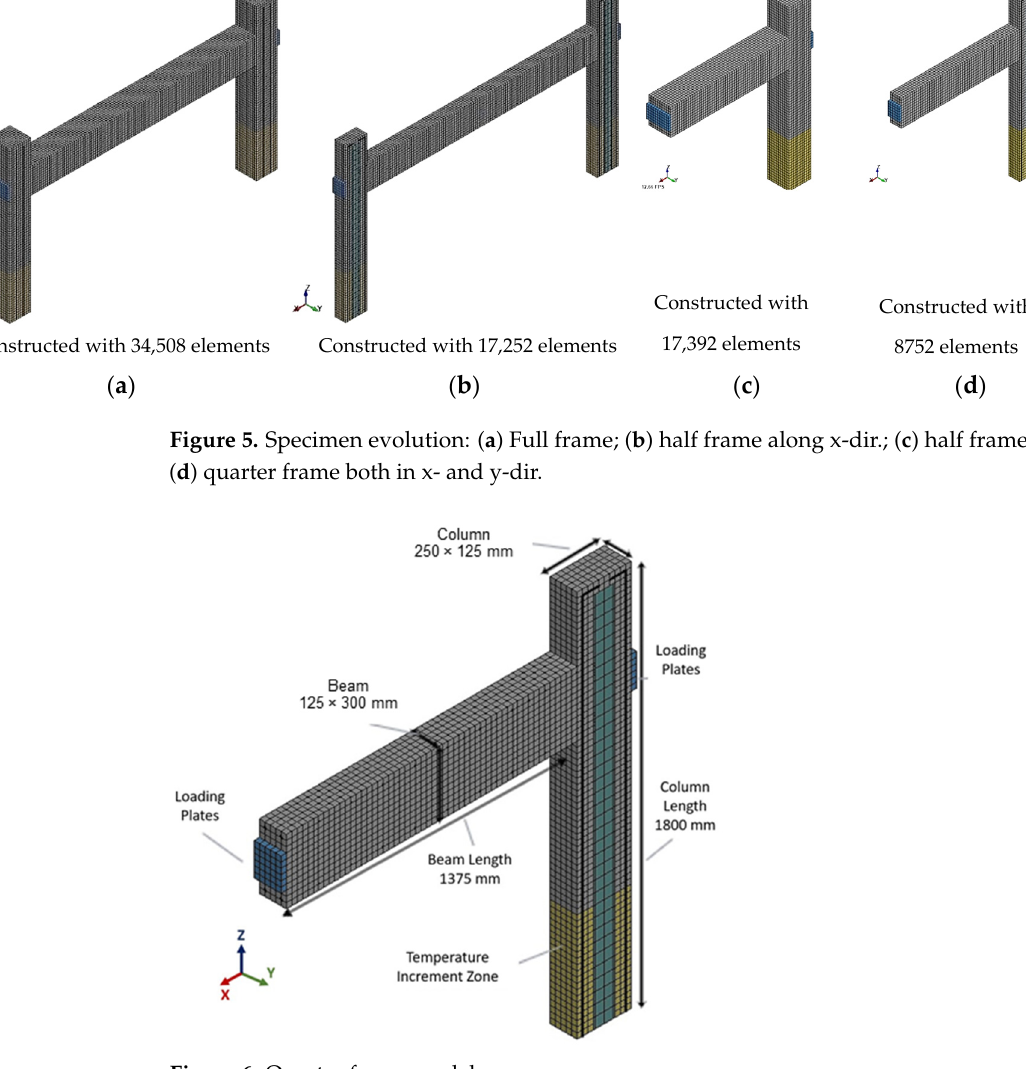
Figure 6. Quarter frame model.